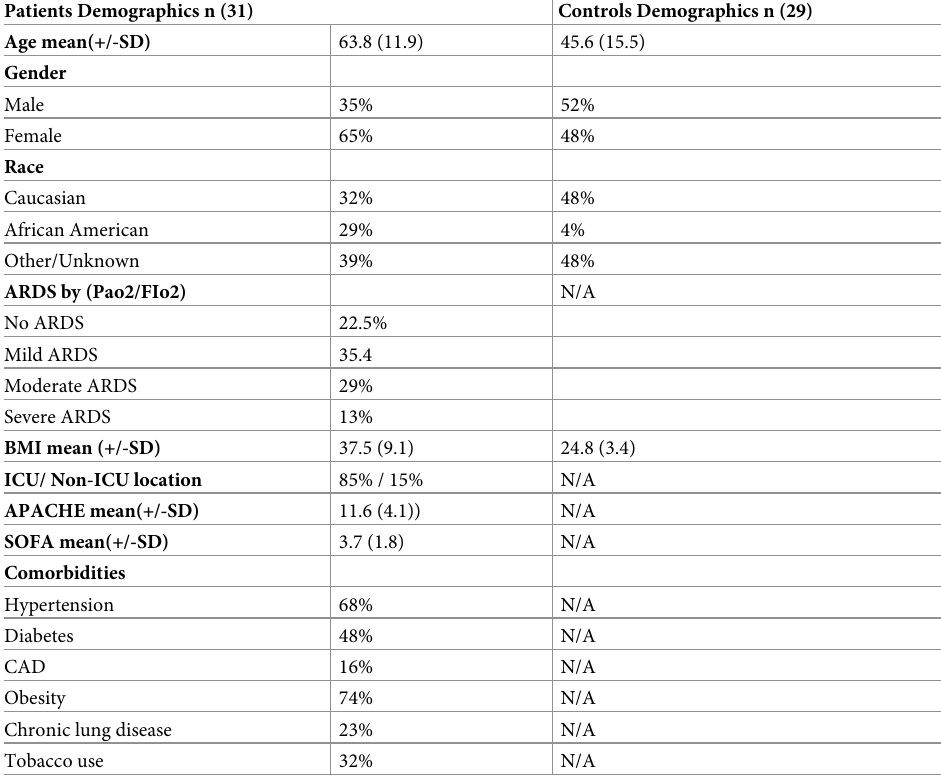
Table 1. Baseline characteristics of the study